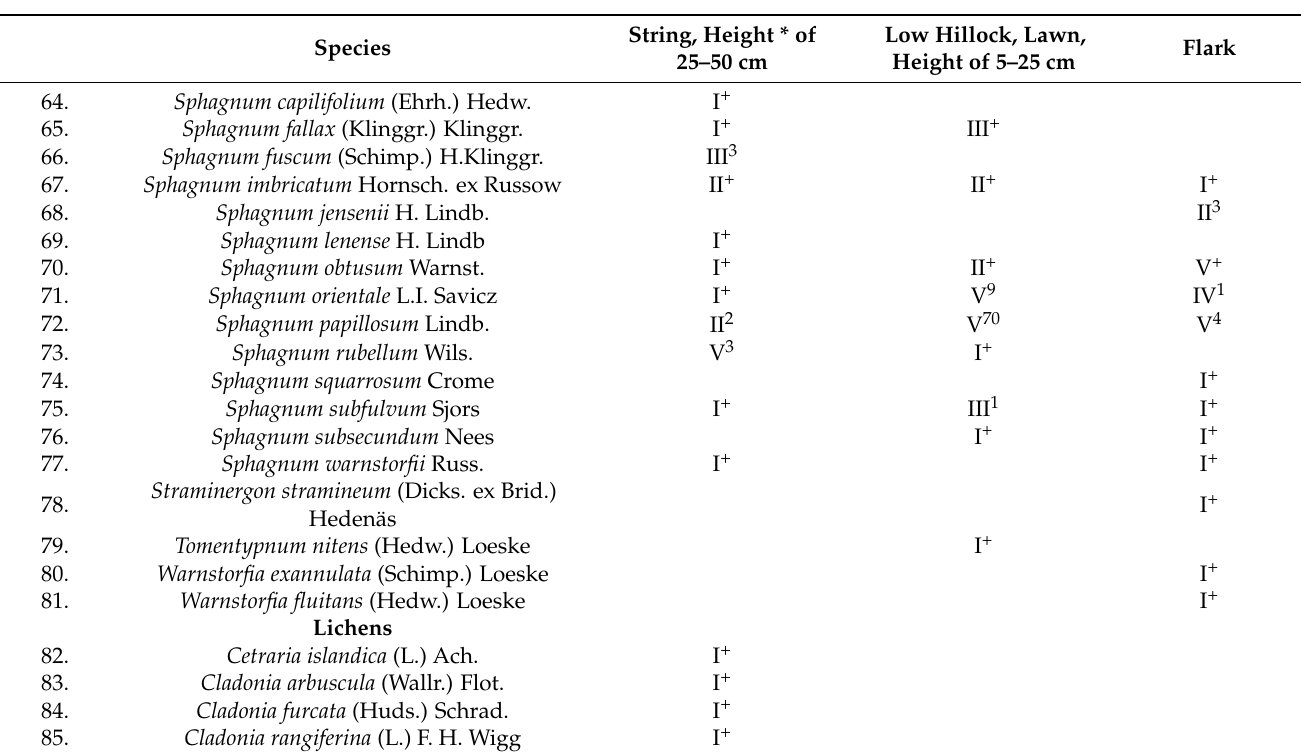
Low Hillock, Lawn, Height of 5–25 cm